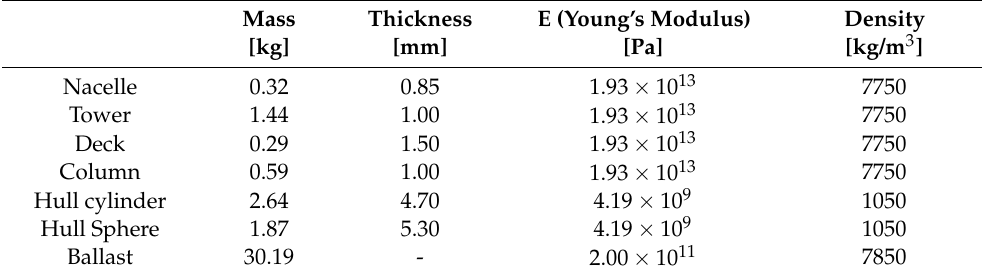
Table 4. Main properties of the Ansys model as constructed in the model